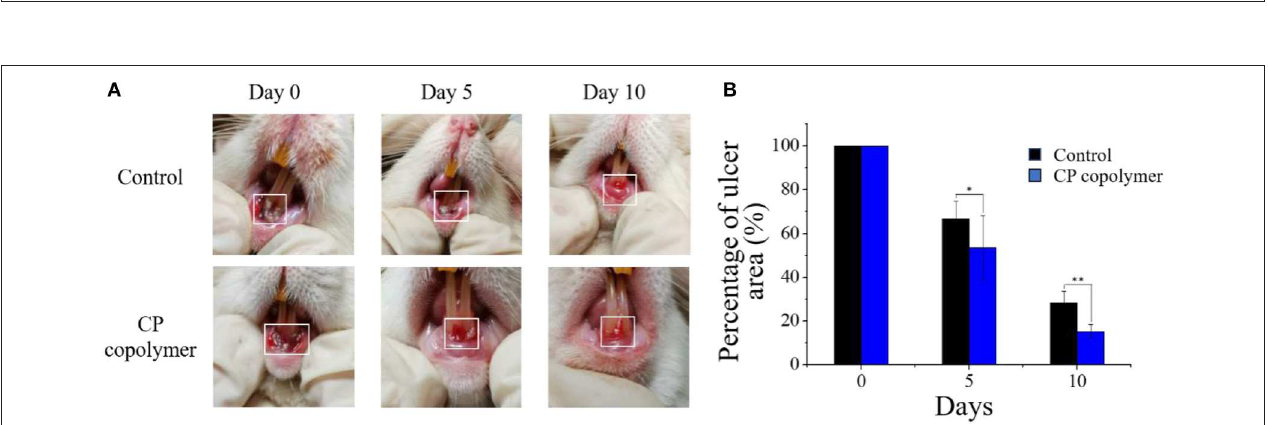
FIGURE 5 | In vivo evaluation of the healing effects of the CP copolymer on oral gingival mucosa ulcers. (A) Photographs of the oral gingival swelling model in Wistar rats treated with the CP copolymer. (B) Gingival swelling areas were measured after dropping normal saline and the CP copolymer onto the ulcerated area. * p < 0.05,** p <